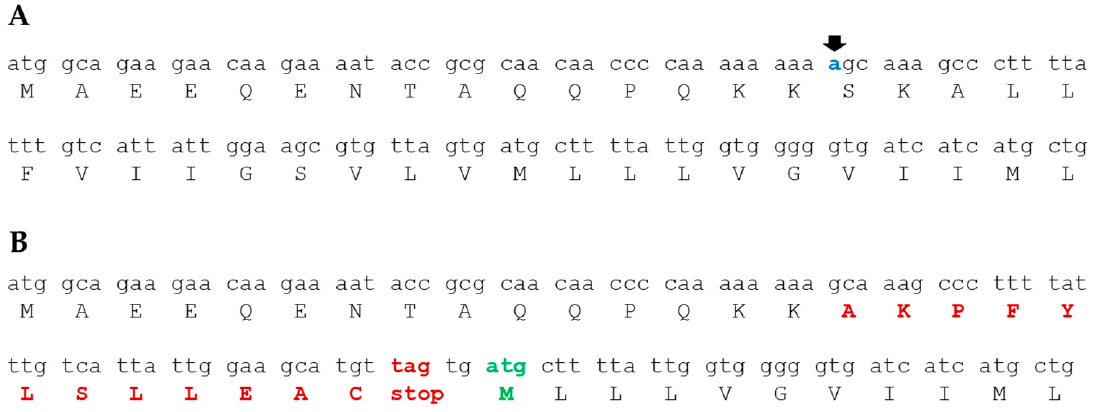
Figure 5. The fliL frameshift mutation in the motile variants of the ∆ hp1487 / hp1486 mutant. ( A ) Nucleotide sequence of first 40 codons of wild-type H. pylori B128 fliL and translated amino acid sequence. The A residue that is deleted in all three ∆ hp1487 / hp1486 motile variants is indicated in blue type and by the arrow. ( B ) Nucleotide and corresponding amino acid sequences of fliL from the ∆ hp1487 / hp1486 motile variants. The altered amino acid sequence following the frameshift mutation is indicated in red type. A potential start codon that brings the nucleotide sequence into the correct reading frame is indicated in green type.